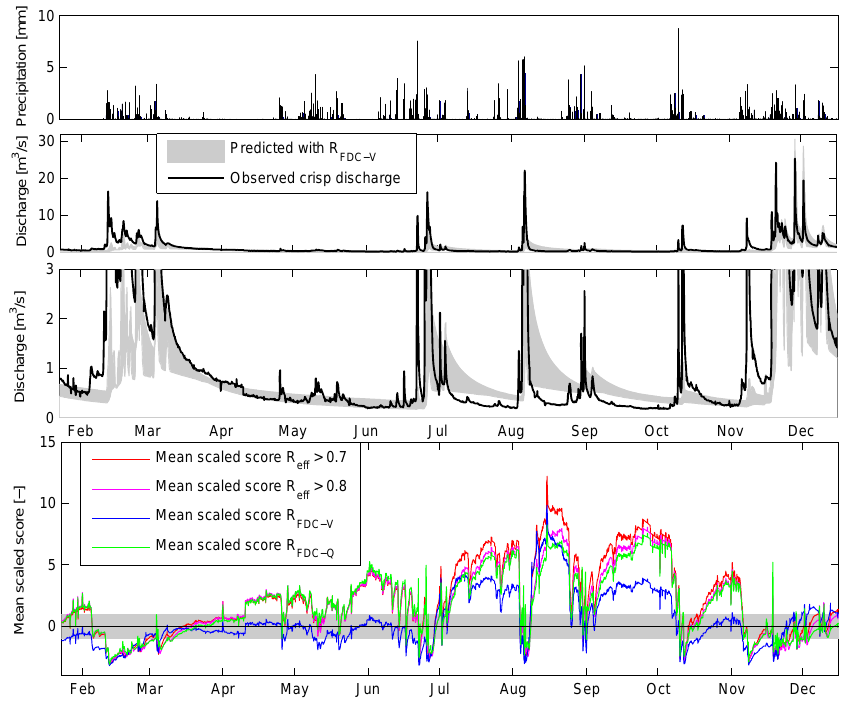
Fig. 16. Predicted and observed crisp discharge for 1997–1998 for behavioural parameter-value sets for R FDC − V from calibration using Dynamic TOPMODEL in 1995–1996 for the Brue catchment (upper plot shows the whole flow range, middle the low flows). The mean scaled scores for all performance measures are plotted in the bottom plot where the grey area represents a scaled score from − 1 to 1, i.e. a simulated discharge with a score inside this range is inside the discharge uncertainty limits. The R FDC − V criterion gave simulations with less overprediction in the summer. In July–October 1997 there was a period of consistent overprediction at low flows for all performance measures where the model could not reproduce the